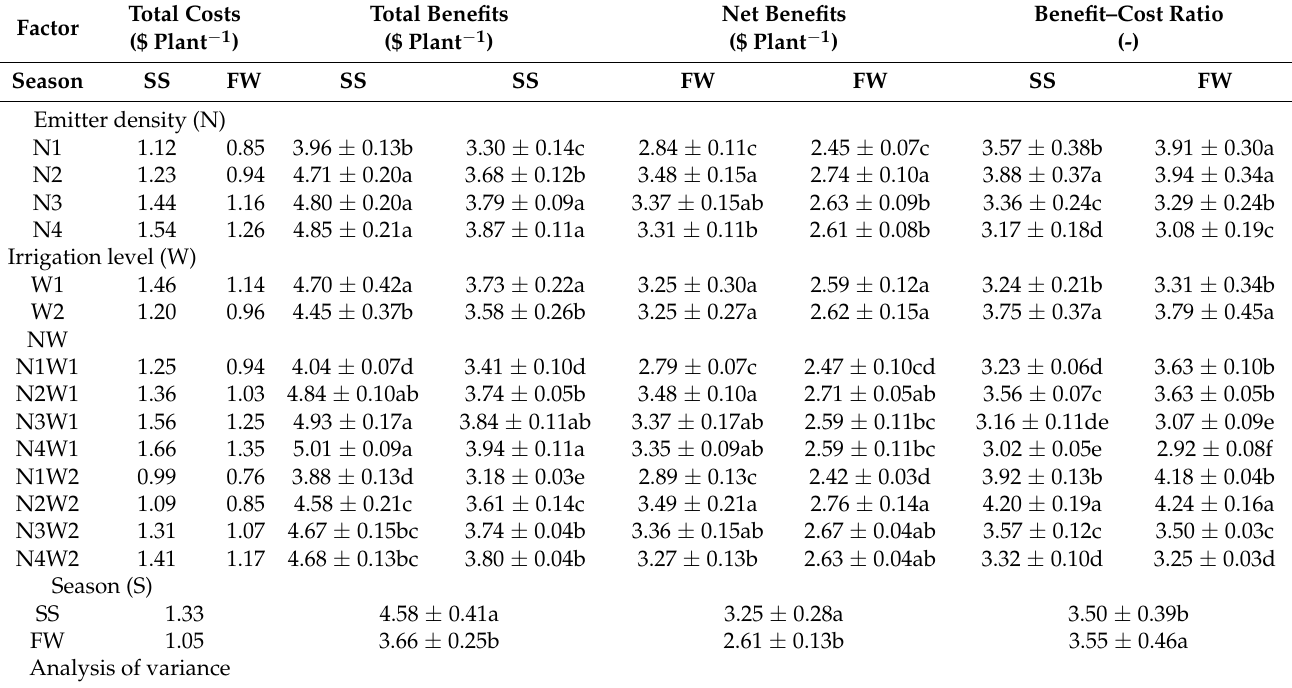
Table 3. Effects of emitter density, irrigation level, and season on economic analysis for both SS and FW.